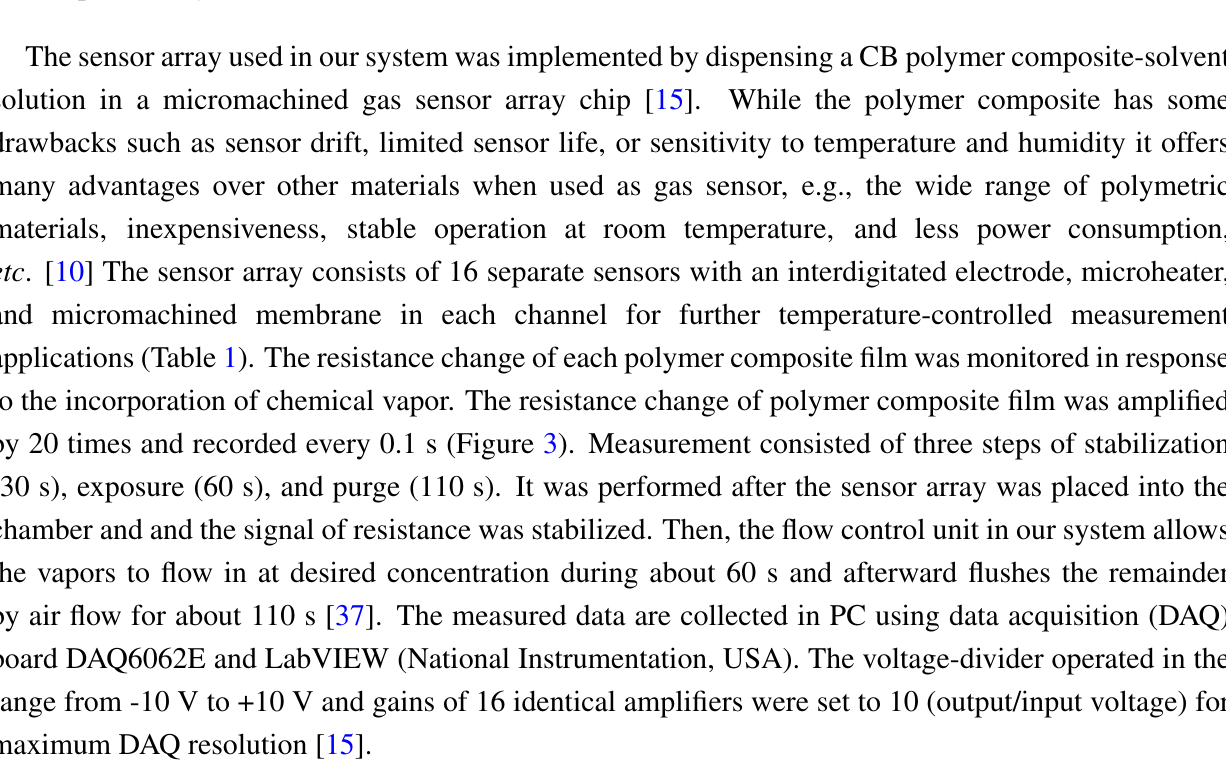
Table 1. The list of 16 CB polymer composites used in the sensor